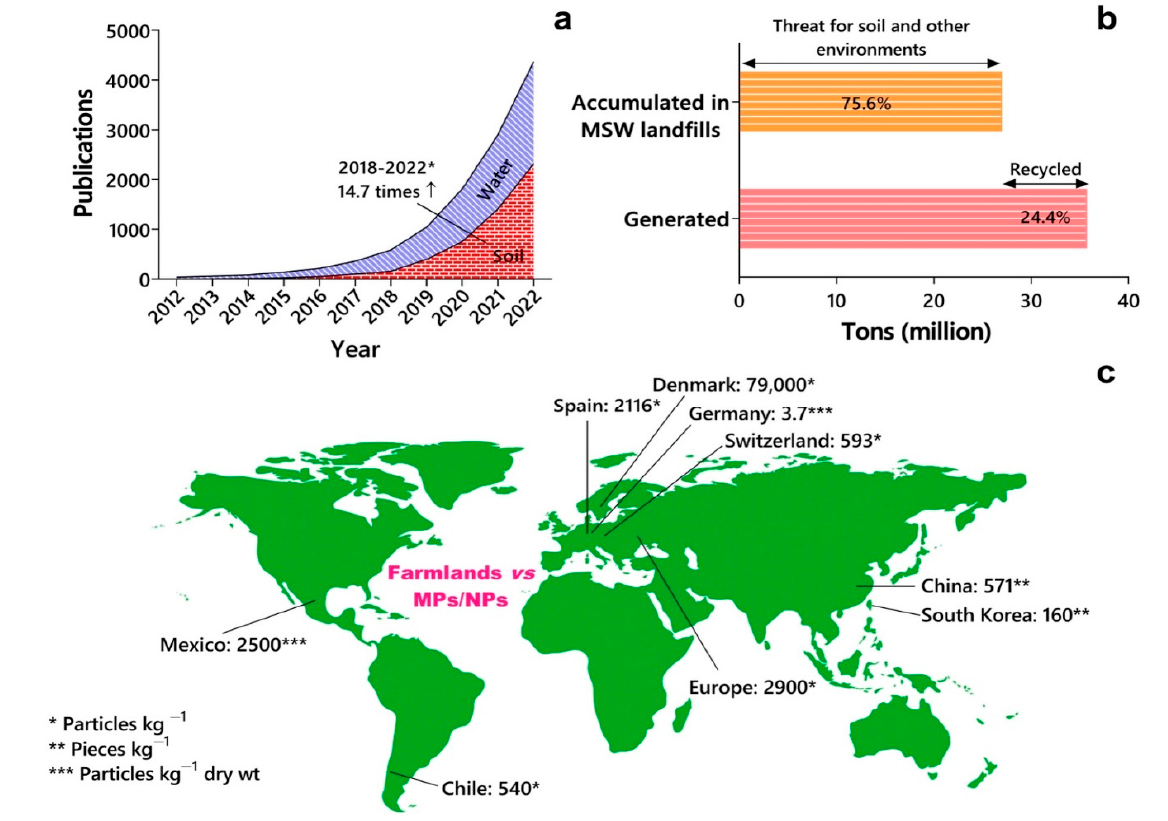
Figure 1. Microplastics (MPs)/nanoplastics (NPs)—a global scenario. ( a ) Publication of scientific articles from 2012–2022 *. Data collected from ScienceDirect using “microplastics + water” and “microplastics + soil” keywords (* as of 30 October 2022). ( b ) Amount of MPs generated and accumulated in municipal solid waste (MSW) landfills in USA in 2018 [41]. ( c ) Occurrence of MPs in farmland soils in different countries